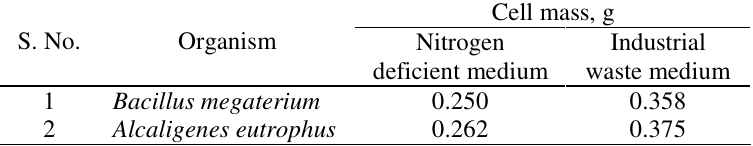
Table 1. Cell dry weights in sugarcane effluent with different